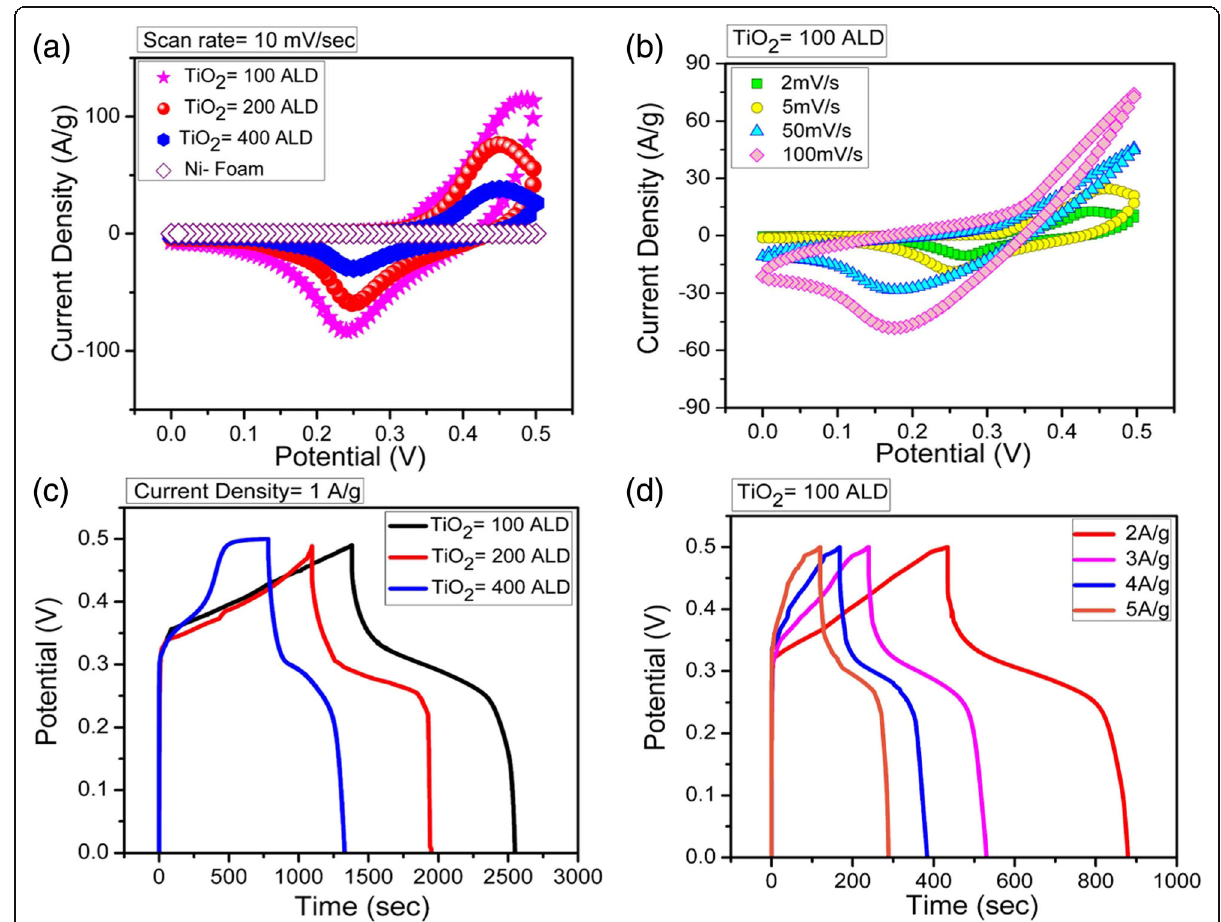
Fig. 3 Electrochemical characterization of TiO 2 NMs supercapacitor. a CV curves of pure Ni-foam, electrodes made from TiO 2 NMs with 100, 200, and 400 ALD cycles. The scan rate is 10 mV/s. b CV curves of electrode made from TiO 2 NMs with 100 ALD cycles, obtained at different scan rates. c CP curves of electrode made from TiO 2 NMs with 100, 200, and 400 ALD cycles. The current density is 1 A/g. d CP curve of electrode made from TiO 2 NMs with 100 ALD cycles, obtained at different current